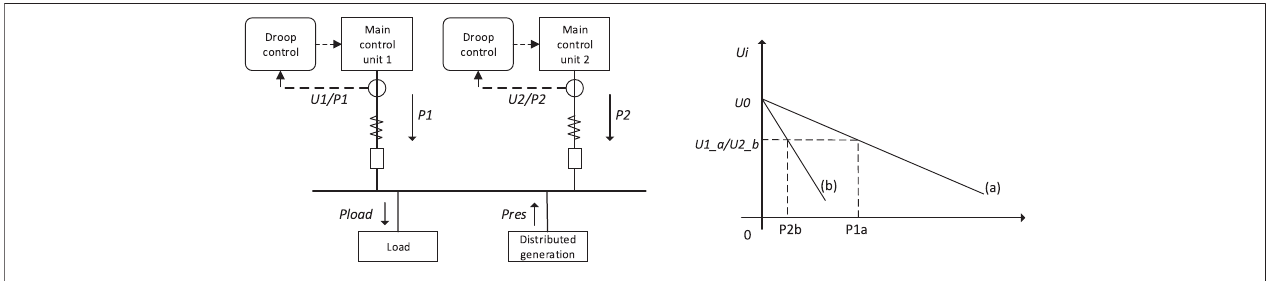
FIGURE 4 | Control schematic diagram of parallel operation of two droop control units.